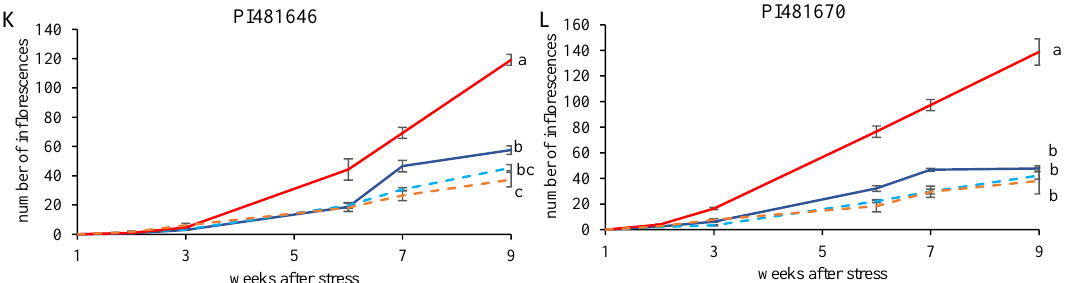
Figure 4. Inflorescence production of F. tataricum varieties subjected to two temperatures (21 ◦ C vs. 28 ◦ C) and water supply conditions (well-watered vs. water-stressed). Varieties ( A ) Islek, ( B ) Zlata, ( C ) Lifago, ( D ) PI481659, ( E ) PI481656, ( F ) PI481671, ( G ) PI481652, ( H ) PI427239, ( I ) PI476852, ( J ) PI481644, ( K ) PI481646, and ( L ) PI481670. 21WW: 21 ◦ C well-watered, 21WS: 21 ◦ C water stress, variety were not statistically significant at the 5% level at the end of the experiment. Independently of the environmental condition, Islek was the first variety to flower after a mean value (all conditions combined) of 24 days after treatment, while PI481644 was the latest to flower after a mean value of 43 days after treatment (Figure 5A). PI476852 was the first variety to flower in terms of flowering node, while PI481644 was the latest; the mean node with the first inflorescence varied from 4.7 to 7.9. Temperature and watering